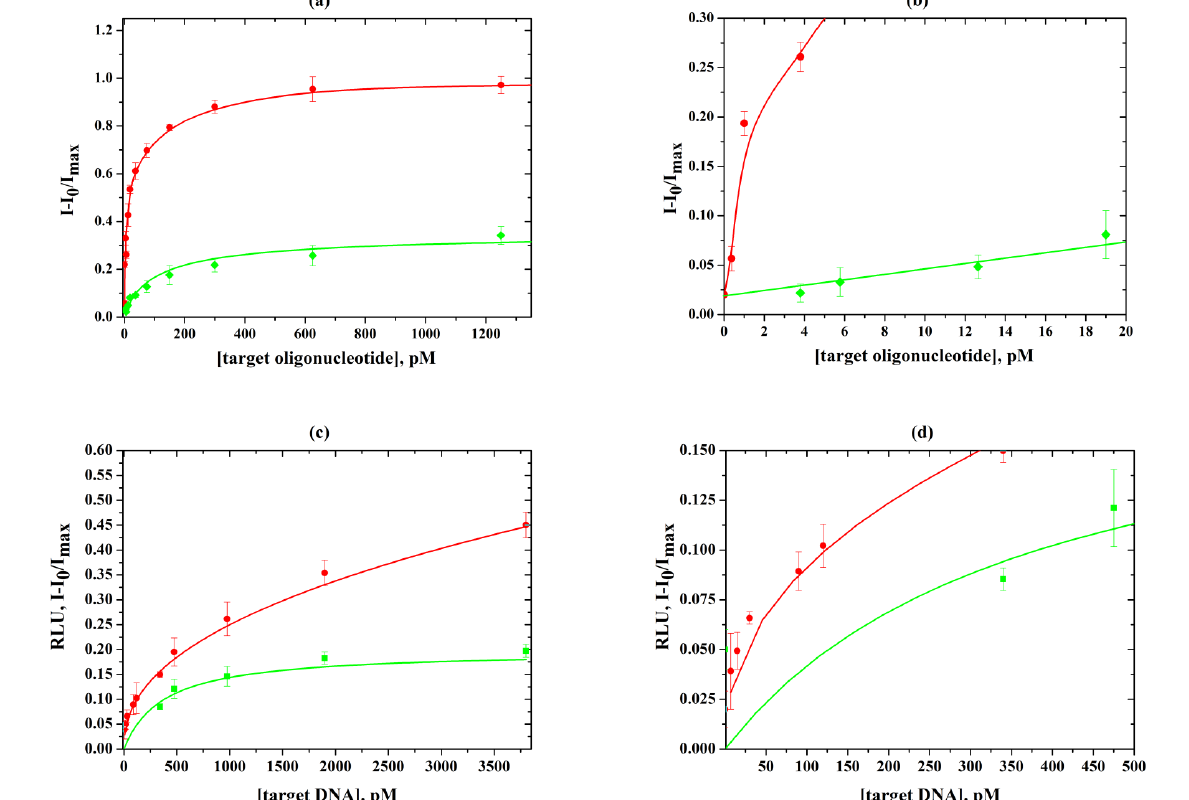
Figure 9. Calibration curves for the determination of short oligonucleotide of 19 bases ( a ) and long DNA of 860 bp, containing bla TEM-1 ( c ); enlarged sections of the calibration curves for low concentrations of short oligonucleotide ( b ) and long DNA ( d ). Green lines correspond to standard detection without enhancement; red lines correspond to the detection of AuNP labels with an enhancement solution at optimized concentrations and pH.